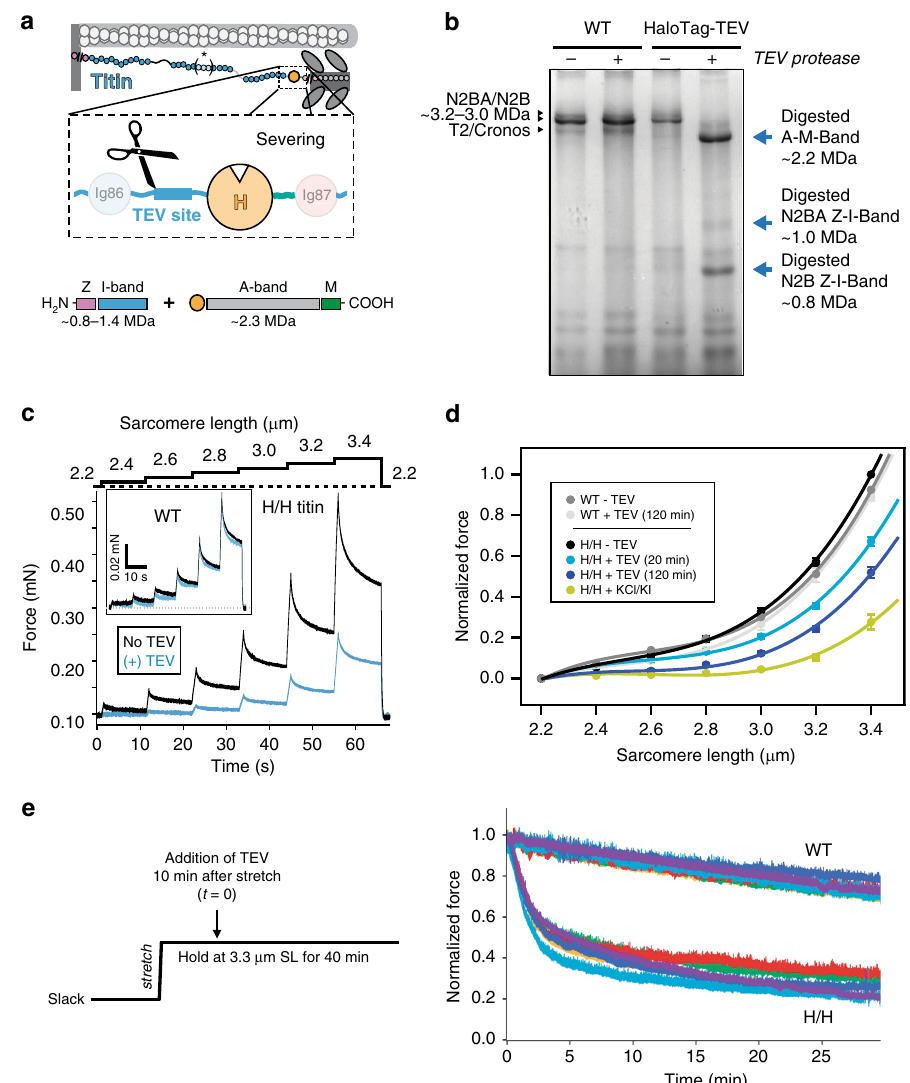
Fig. 2 Directed severing of HaloTag-TEV titin. a Following treatment with TEV protease, the HaloTag-TEV titin is expected to result in at least two fragments: A-M-band fragment (~2.2 MDa) and the Z-disk/I-band fragment(s), which can show a range of molecular weights depending on the speci fi c titin isoform (represented by asterisk and brackets in the titin diagram). b Digestion of cardiac titin is tracked by 1.8% polyacrylamide SDS-PAGE electrophoresis and Coomassie staining (a representative image of 20 experiments showing the same result). Wild-type titin is not affected by incubation with TEV protease, so typical bands corresponding to full size N2BA/N2B isoforms and to the T2 fragment or the Cronos isoform are observed in both lanes. In contrast, digestion of HaloTag-TEV titin results in a main band at 2.2 MDa, corresponding to the A-M-band fragment, and two extra bands at 0.8 and 1.0 MDa that are assigned to the I-band portions of the N2B and N2BA cardiac isoforms, respectively. c Passive stiffness of skinned bundles of psoas myo fi bers isolated from homozygous HaloTag-TEV titin mice (H/H). During mechanical testing, myo fi bers were stretched in steps to increasing sarcomere lengths, and the resulting passive force was recorded. Force was fi rst measured in relaxing buffer, then myo fi bers were incubated with TEV for 30 min at slack length (2.2 μ m), and the measurement was repeated. Inset: control experiment with wild-type fi bers. d The drop in passive force that results from incubation of HaloTag-TEV titin fi bers with TEV protease is time-dependent (in these experiments, H/H fi bers were returned to slack length between consecutive mechanical tests at 10, 20, 40, and 120 min; data at 10 and 40 min are not presented for clarity). After 120 min, high ionic strength KCl/KI buffer was added to extract titin. To average several experiments ( n = 6), force values are normalized to the value at 3.4 μ m SL before treatment with TEV. Error bars represent SEM. Source data are provided as a Source Data fi le. e Mechanical testing at long sarcomere lengths. Left: Experimental protocol. Right: Results from six independent experiments using ~150- μ m-diameter skinned psoas fi